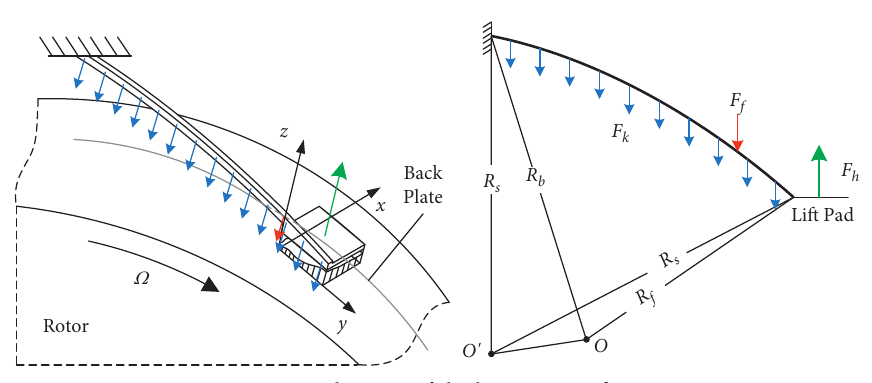
Figure 3: Schematic of the low-pressure